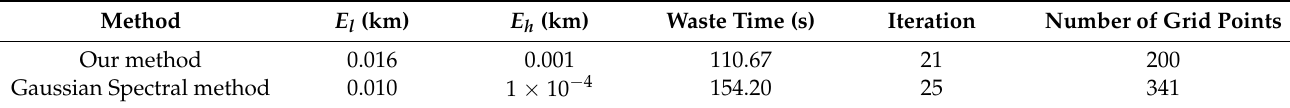
Table 4. Generation effect of different